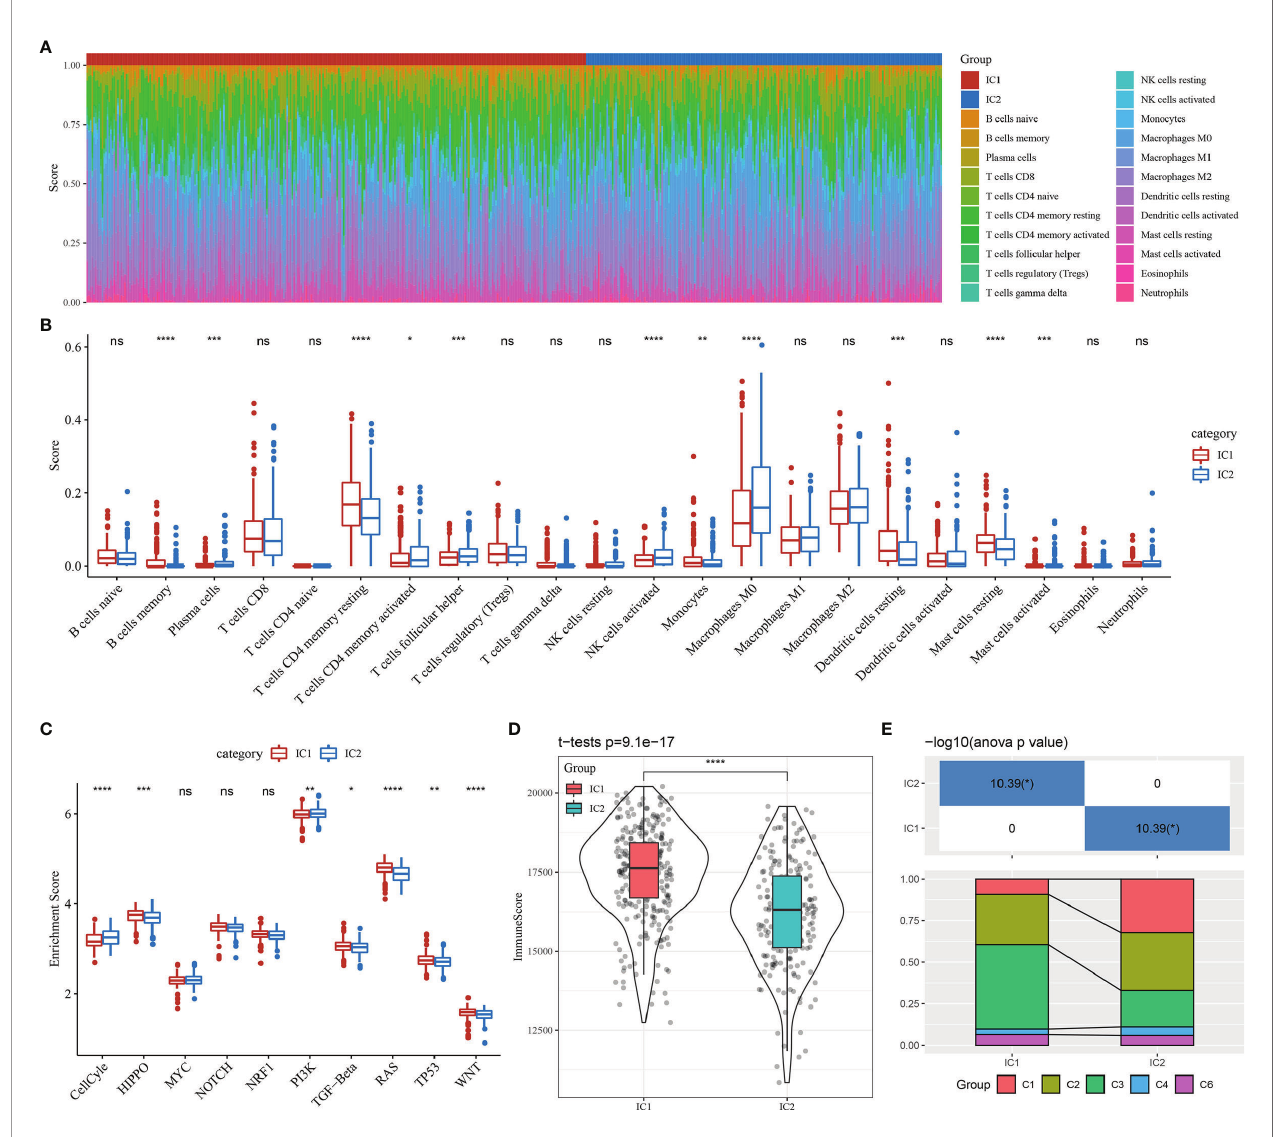
FIGURE 6 | Immunological features and pathway characteristics of molecular subtypes. (A) Proportions of 22 immune cell types in molecular subtype samples. (B) Differences in immune cell scores of 22 immune cell components between molecular subtype samples. (C) Differences in enrichment scores of ten pathways associated with tumor abnormalities between molecular subtypes. (D) Distribution of immune in fi ltration scores between molecular subtype samples. (E) Comparison of the molecular subtypes with fi ve previously identi fi ed pan-cancer immunophenotypes. *p < 0.05; **p < 0.01, ***p < 0.001, ****p < 0.0001; ns, no signi fi